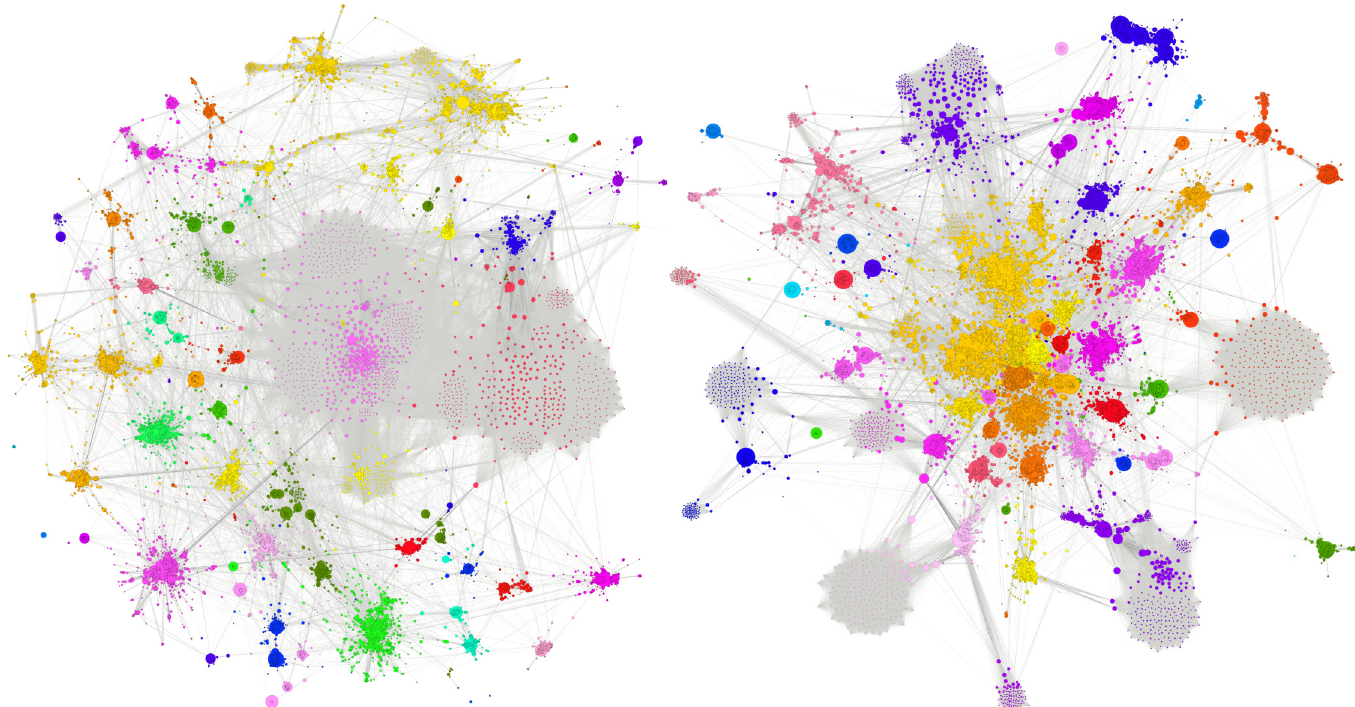
Fig 1. Nobel Laureate Coauthor Network (left) and Non-Laureate Coauthor Network (right). Network graphs were produced in Gephi, using the Force Atlas 2 layout, a variant of the Fruchterman-Reingold algorithm with stronger clustering. Linlog mode was used with scaling set to 0.2 and gravity to 10. After applying the Force Atlas 2 layout, Noverlap was used to prevent nodes from overlapping [27]. Node coloring is based on modularity class, identified using the Blondel et al. [18] algorithm.